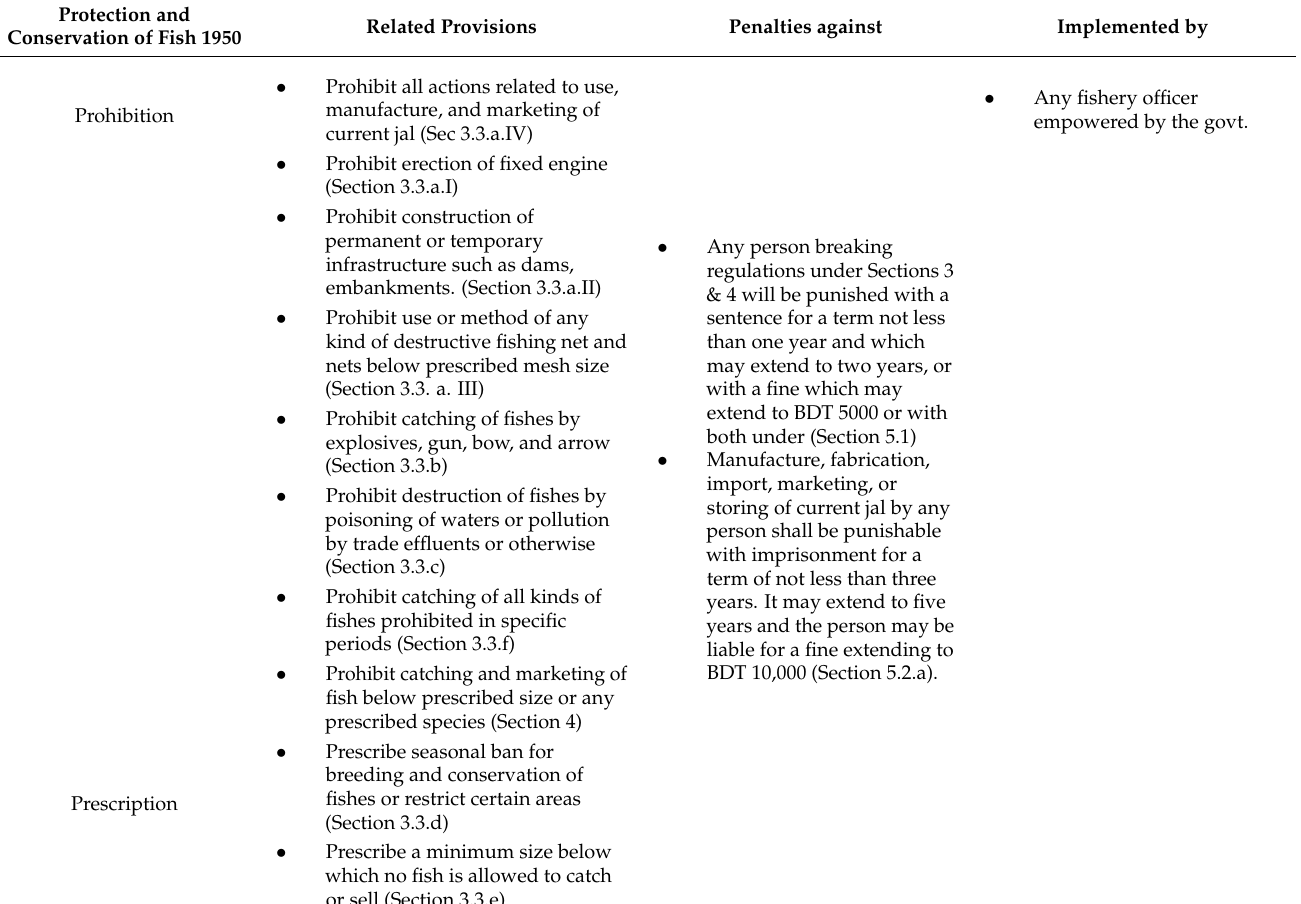
Table 2. Major components of the Protection and Conservation of Fish Act of 1950 and relevant management for Kaptai Lake Fisheries management